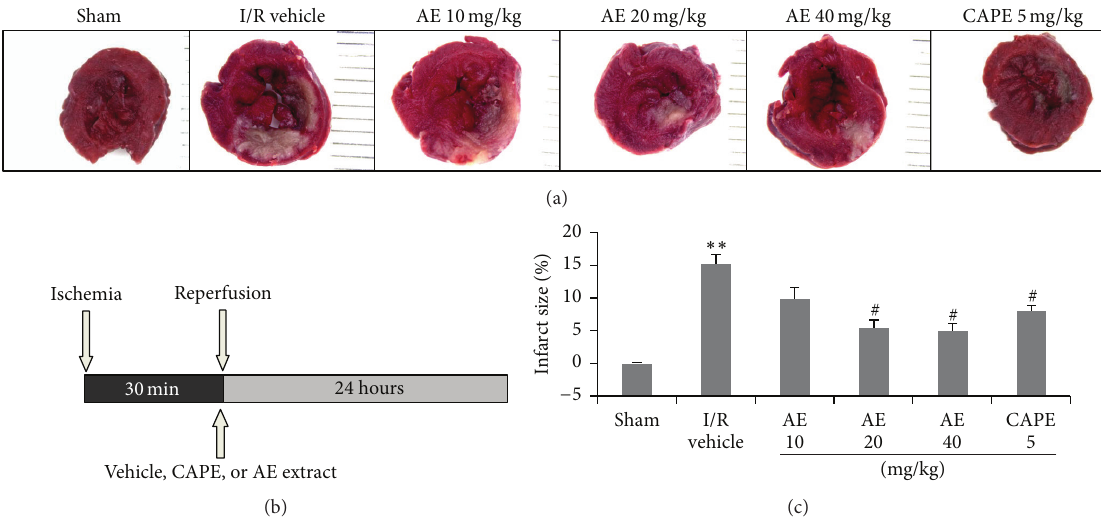
Figure 2: Effects of AE on myocardial infarct size after I/R in rats. (a) Representative TTC stained left ventricle slices are shown. Deep red-staining areas indicate normal tissue and unstained pale areas indicate infarct tissue. (b) Experimental protocol. Hearts were subjected to 30 min ischemia followed by 24-hour reperfusion. Different doses of AE (10, 20, or 40 mg/kg), CAPE 5 mg/kg, or saline (1mL/kg) were administered via the tail vein 1min before reperfusion. (c) Myocardial infarct size determined by TTC staining. 𝑛 = 5 /group. ∗∗ 𝑃 < 0.01 , versus Sham; # 𝑃 < 0.05 versus I/R vehicle.